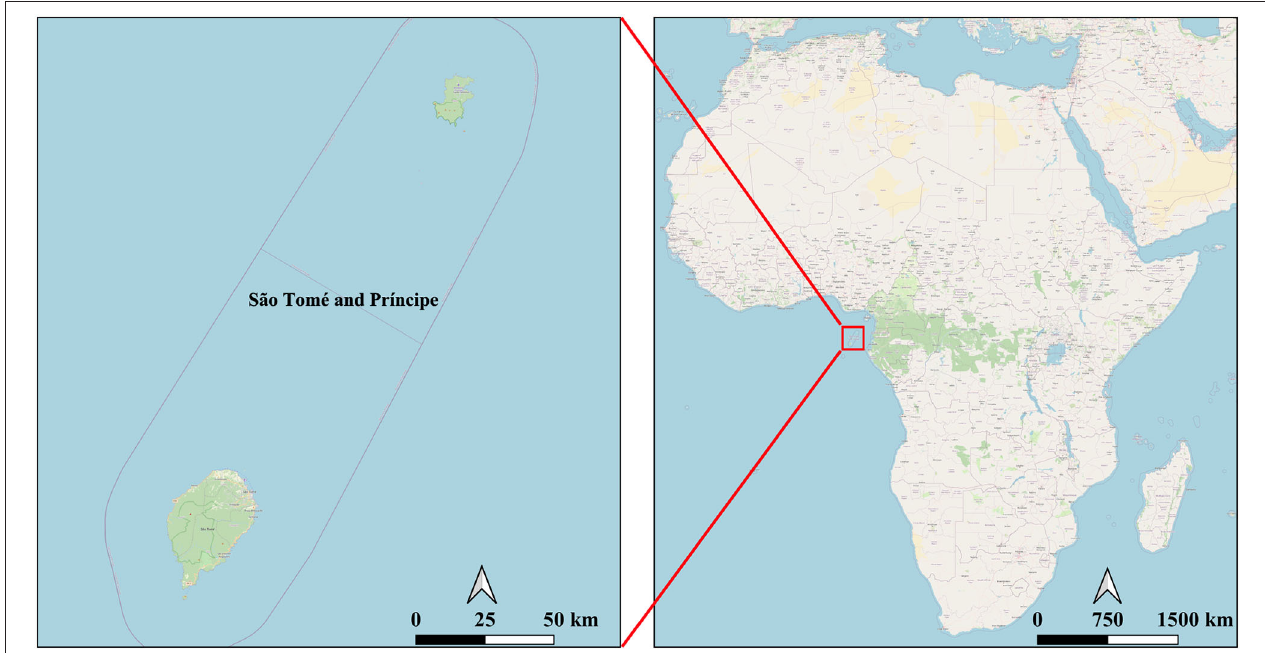
FIGURE 1 | Geographical location of SãoTomé and